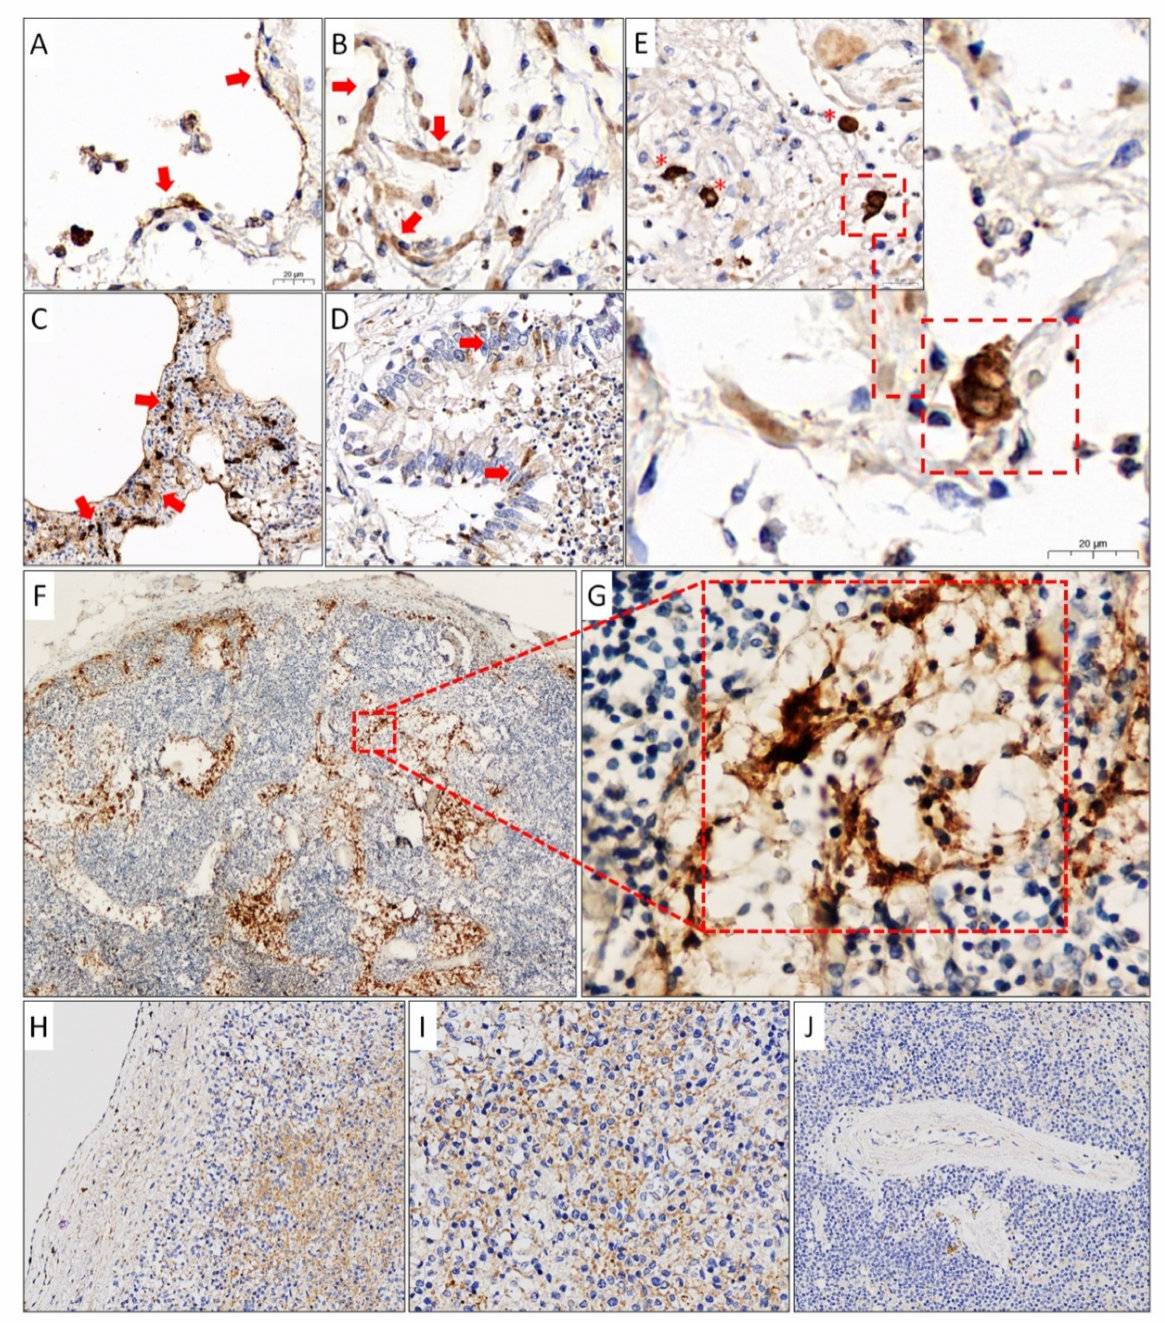
Figure 4. Results of an immunohistochemical study of lung tissues ( A–E ), tracheobronchial lymph nodes ( F , G ), and spleen ( H–J ) using mAb against SARS-CoV-2 NC protein. ( A ) Positive staining of type 1 pneumocytes (red arrows) and cells in the lumen of the alveoli ( × 600). ( B ) Positive staining of type 2 pneumocytes (red arrows) ( × 600). ( C ) Positive staining of cells of the dilated and thickened alveolar septum (red arrows). ( D ) Desquamated bronchiolar prismatic epithelium with single positively stained cells (red arrows) ( × 400). ( E ) Positive staining for alveolar macrophages (red asterisks) and multinuclear cells (red frame) ( × 400). ( F , G ) Positive staining of hyperplastic sinus histiocytes in the lumen of dilated sinuses of the lymph node ( × 40, × 400). ( H , I ) Positive staining of cells of the Billroth pulp cords, as well as single cells of the spleen capsule ( × 200, × 400). ( J ) Negative staining of cells of the periarterial lymphoid sheaths ( ×